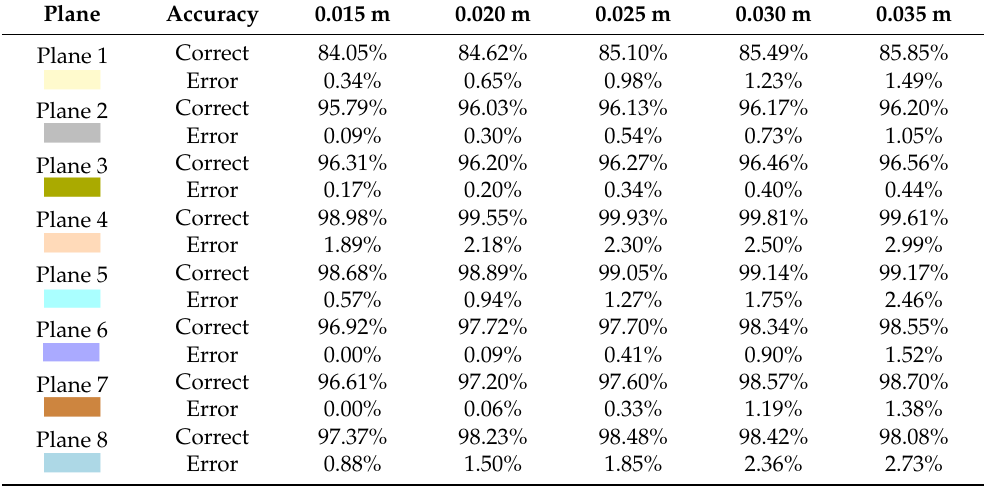
Table 1. Accuracy assessment of cottage’s plane segmentation using the proposed method under different distance thresholds.